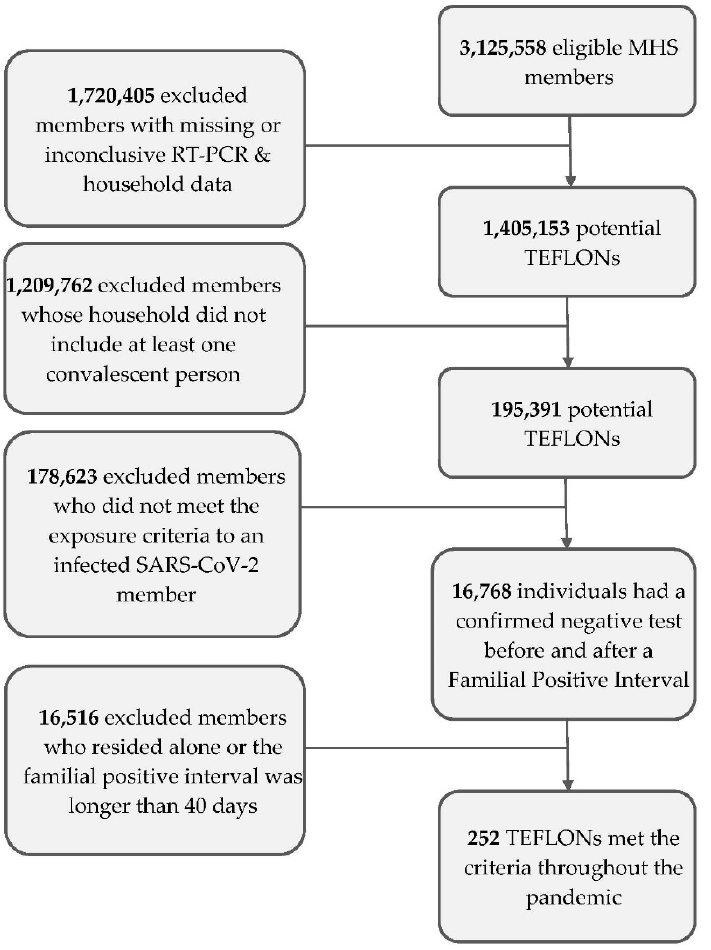
Figure 4. The data investigation process—The right side of the flow chart describes the included population at each step. The left side shows the criteria that were used at each step. MHS, Maccabi Healthcare Services; RT-PCR, reverse transcription polymerase chain reaction; TEFLONs, Timely Exposed to Family members Leaving One Not infected.